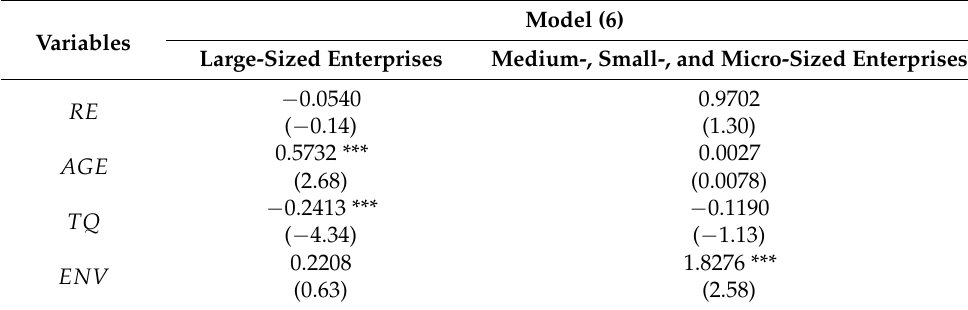
Table 9. Estimation for different enterprise